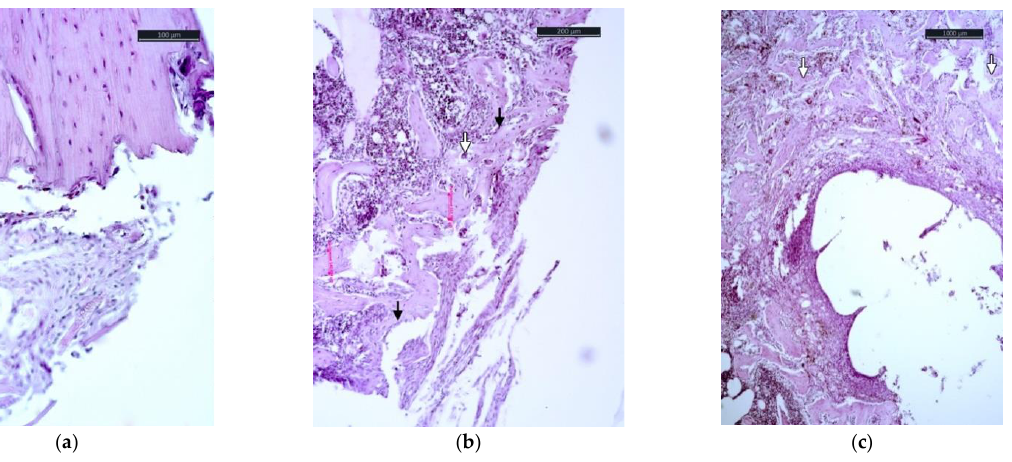
Figure 2. Bone tissue of a rat in the area of a fracture in the femoral diaphysis on the 30th day of the experiment: ( a ) a rat without an implant; in the area of damage among the fibroreticular tissue of the osteoid stripes (marked with an arrow → ), capillary vessels, pericytes of the latter with the onset of transformation into osteoblasts (marked with an arrow ⇒ ); HE × 400. ( b ) a rat with magnesium implants coated with hydroxyapatite; among the fibroreticular tissue, there are bone trabeculae with thin osteoid stripes on the surface and chains of osteoblasts (marked with an arrow → ), slit-shaped vessels (marked with an arrow ⇒ ); HE × 200. ( c ) a rat with a magnesium implant covered with hydroxyapatite sealed with polytetrafluoroethylene; an oblique defect with a picture of the pronounced transformation of the fibroreticular bone into a lamellar spongy bone (arrows mark the formed bone beams). Staining with hematoxylin and eosin, at constant magnification; HE × 100.